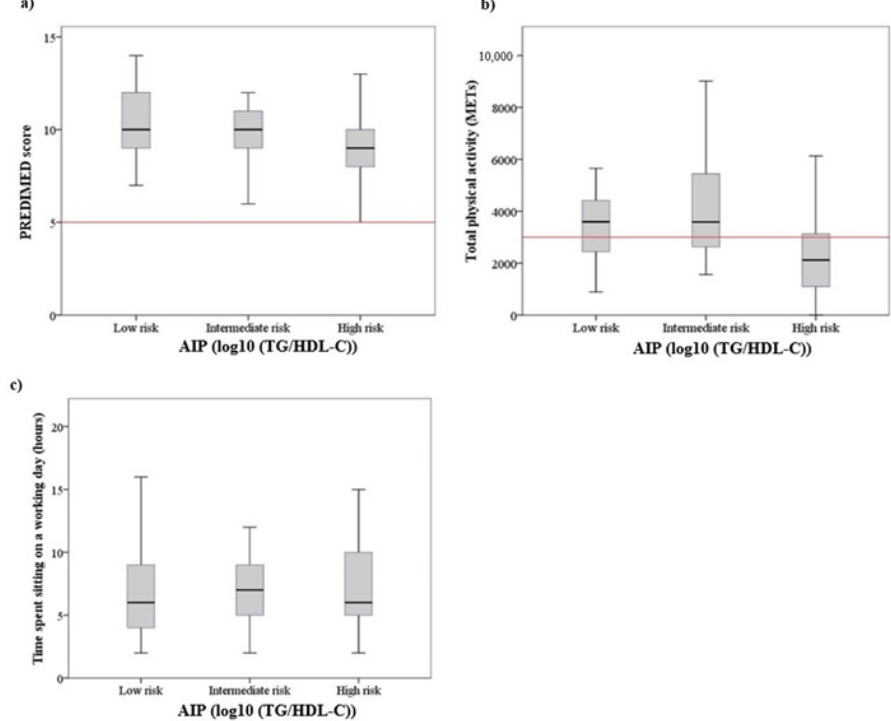
Figure 3. Boxplots of ( a ) adherence to MedDiet, ( b ) physical activity and ( c ) the time spent sitting in a working day, according to the different levels of AIP.